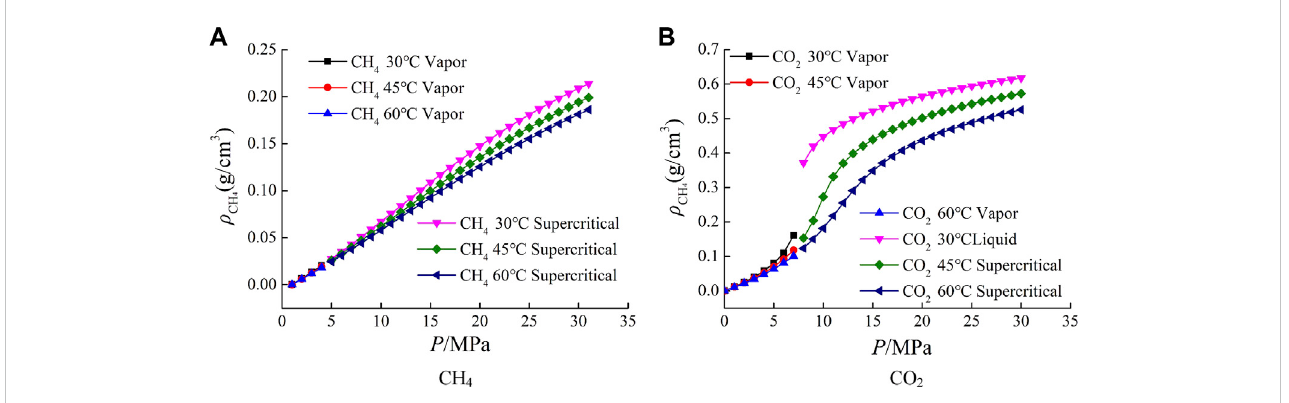
FIGURE 5 The phase change and density curve of CH 4 and CO 2 .